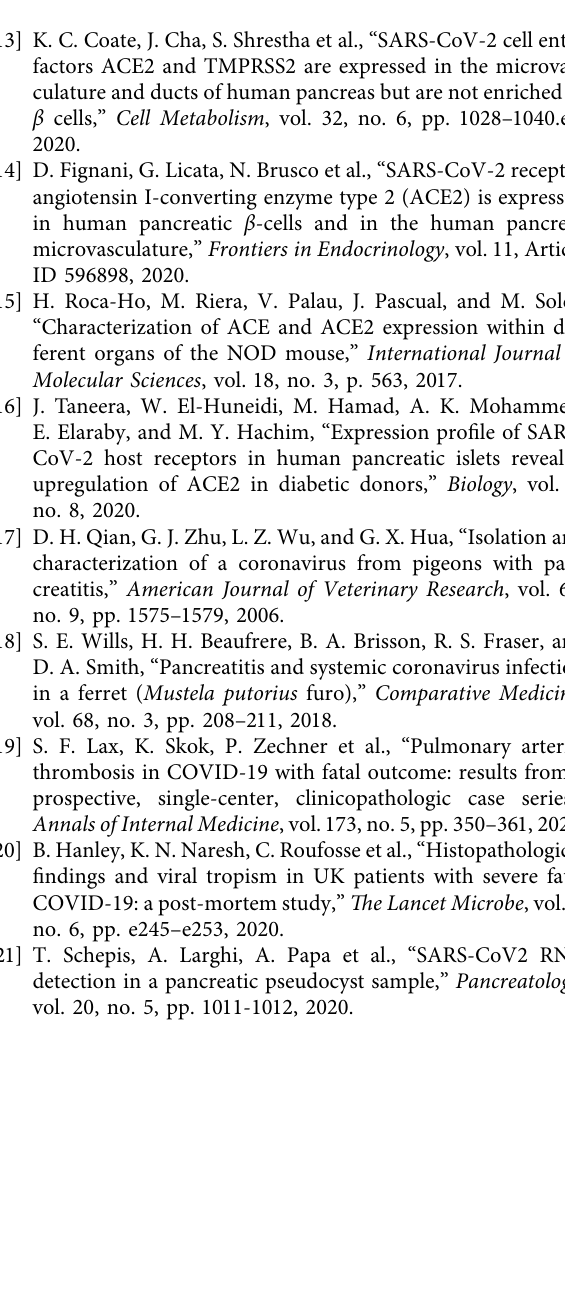
Table S1: reported cases of acute pancreatitis in individuals with COVID-19. ( Supplementary Materials